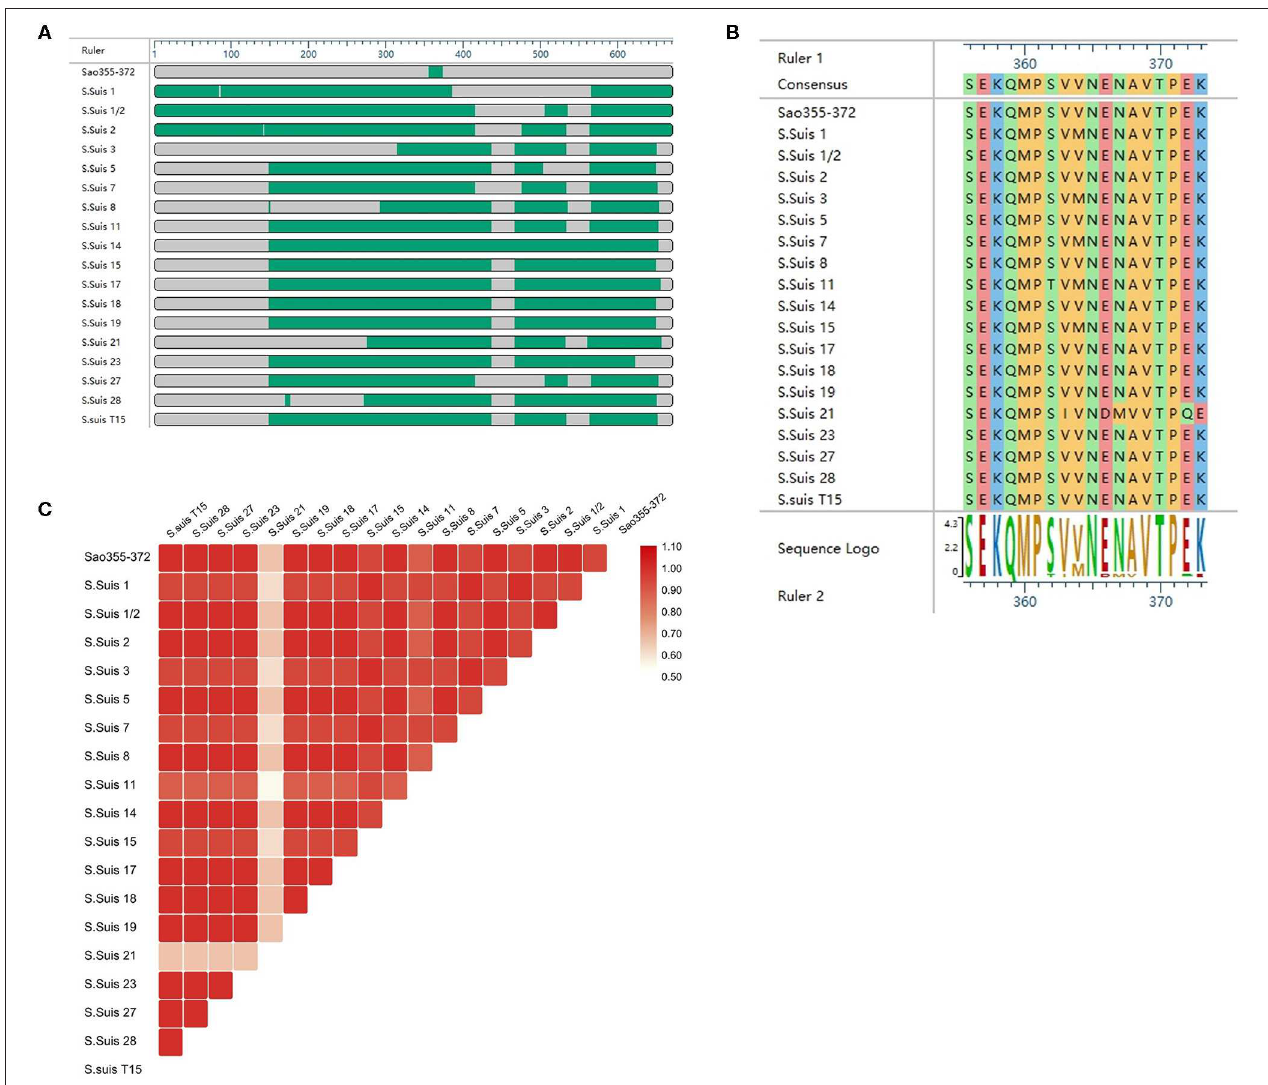
FIGURE 7 | Comparison of the Sao 355 − 372 epitope amino acid sequence among different S . Suis strains. (A) Overview of the comparison results. (B) Amino acid sequence diagram of the alignment result. (C) Heatmap comparing homology between Sao 355 − 372 and 17 other S . Suis strains. Homology was analyzed by DNASTAR and